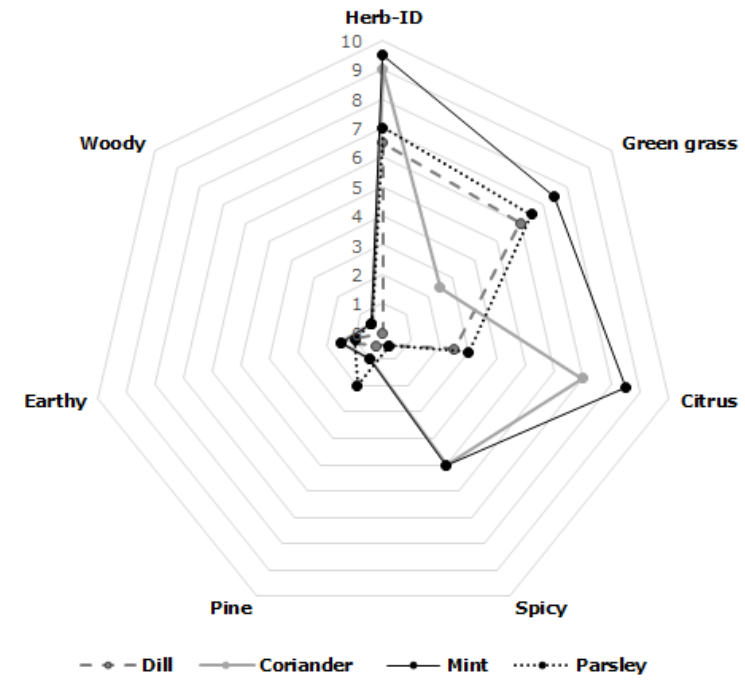
Figure 1. Descriptive sensory analysis of Spanish aromatic herbs.